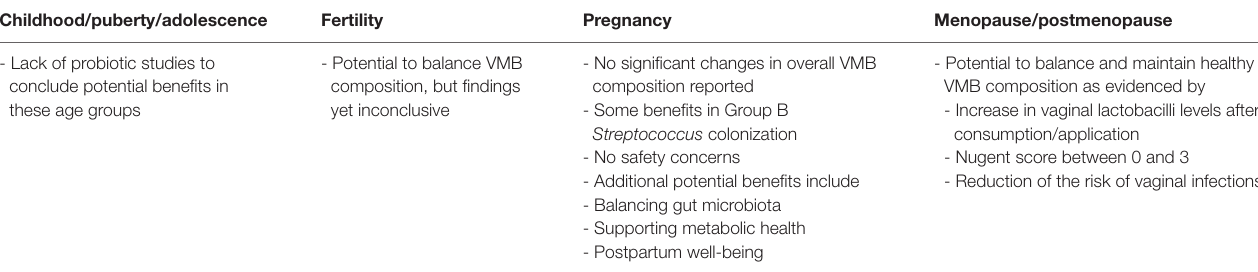
FIGURE 2 | Schematic illustration of typical characteristics and an overview of dominating bacteria in the vaginal environment in context with fluctuating estrogen levels across the female life span. Abbreviations: CST, community state type; VMB, vaginal microbiota. TABLE 1 | Summary of potential benefits of probiotic intervention studies on vaginal microbiota (VMB) throughout female life